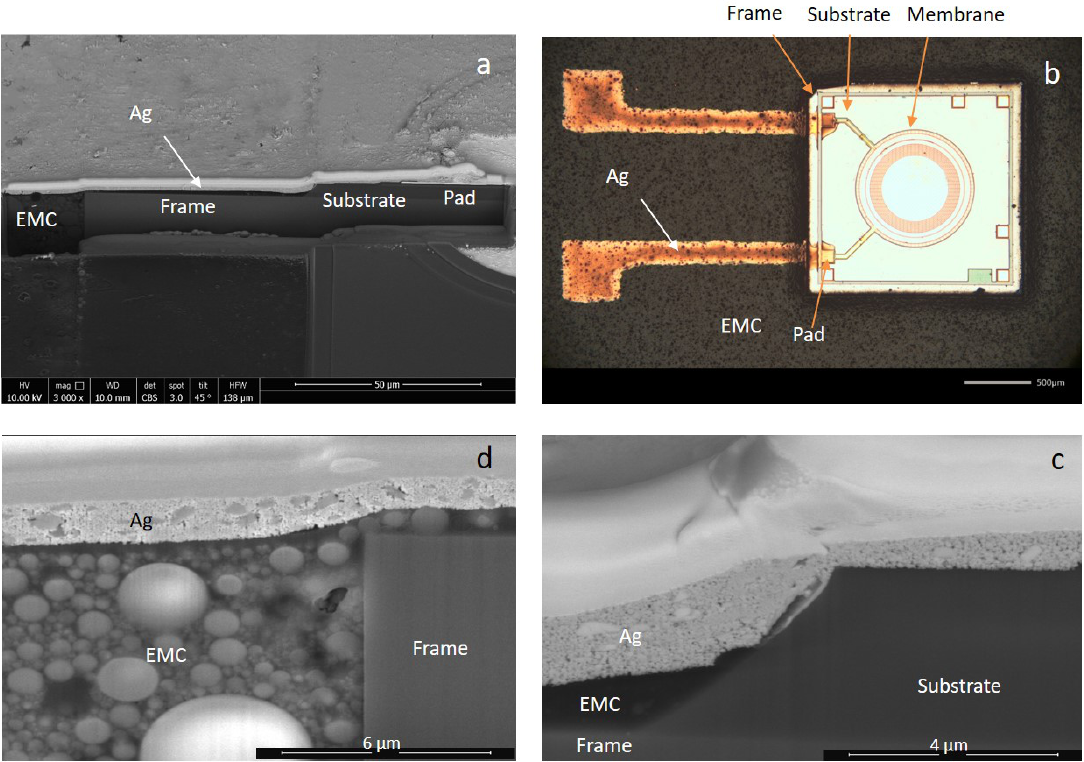
Figure 3. The cross-sectional ( a ) and the planar ( b ) view of the test vehicle comprised of a CMUT microphone with a sensitive membrane and two interconnecting Ag tracks. The critical interfaces between the CMUT substrate-frame ( c ) and CMUT frame-epoxy molding compound (EMC) ( d ) are shown in higher magnifications.